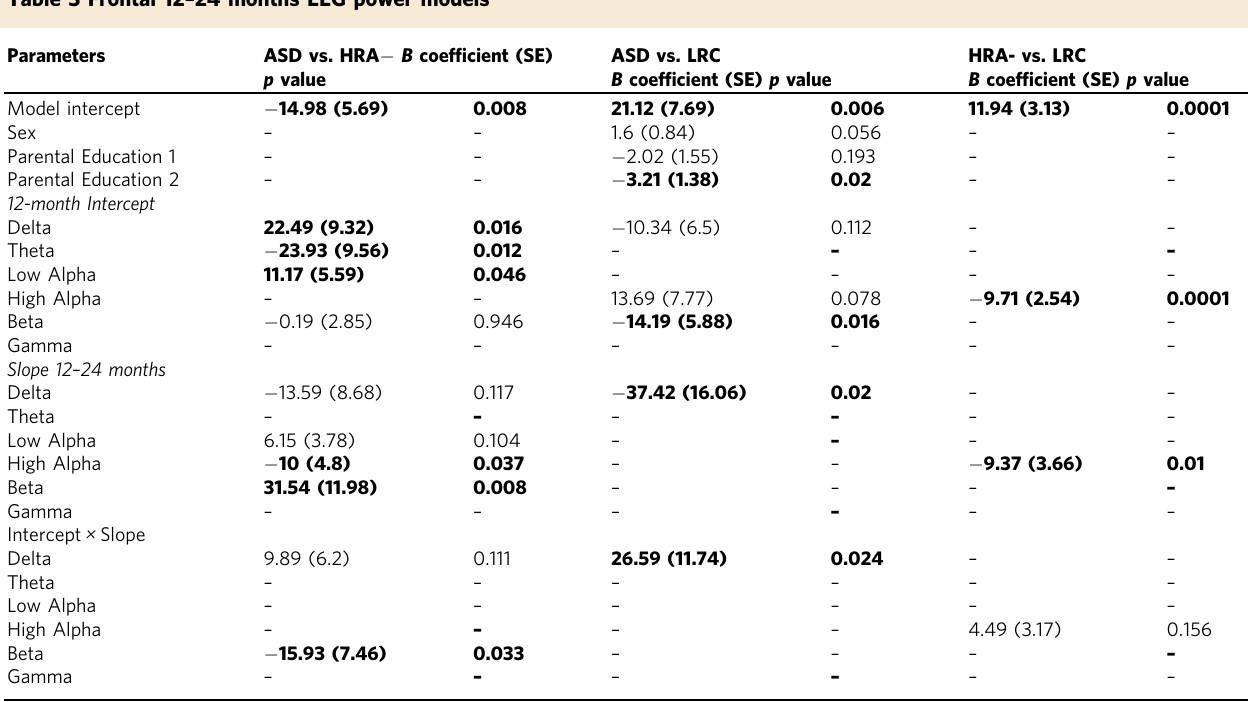
Table 3 Frontal 12 – 24 months EEG power